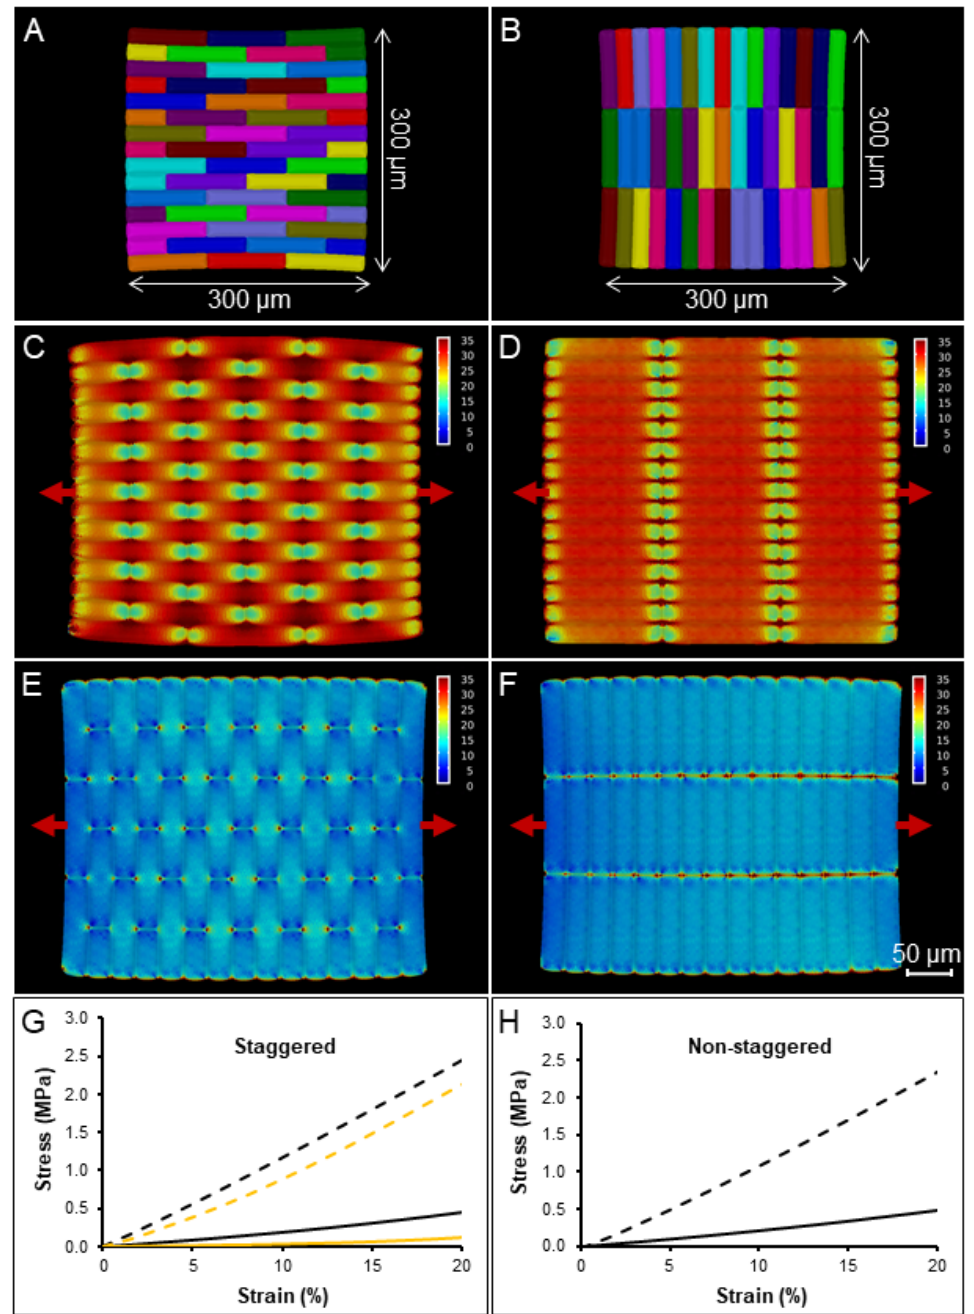
Figure 3. FEM simulation of a tissue with and without cell staggering and anisotropic material properties. ( A , B ) The cell templates were generated with a 5-1 cell ratio in CellMaker. The template used for the simulation was cut to a standard size of 300 × 300 µm in a staggered ( A , C , E , G ) or non-staggered ( B , D , F , H ) patterns. ( C , D ) The longitudinal and ( E , F ) transverse stretch. The heatmaps show the intracellular mechanical stress (trace of Cauchy stress tensor) at 20% strain in the scale from 0 (in blue) to 35 mN (in red). Red arrows indicate the direction of stretch. ( G , H ) Stress–strain curves generated from the FEM simulation in MorphoMechanX for longitudinal (dashed lines) and transverse (solid lines) stretch. Simulation of the staggered tissue stretching was performed also in plasmolyzed conditions ( G , yellow lines). The scale bar is shown in the